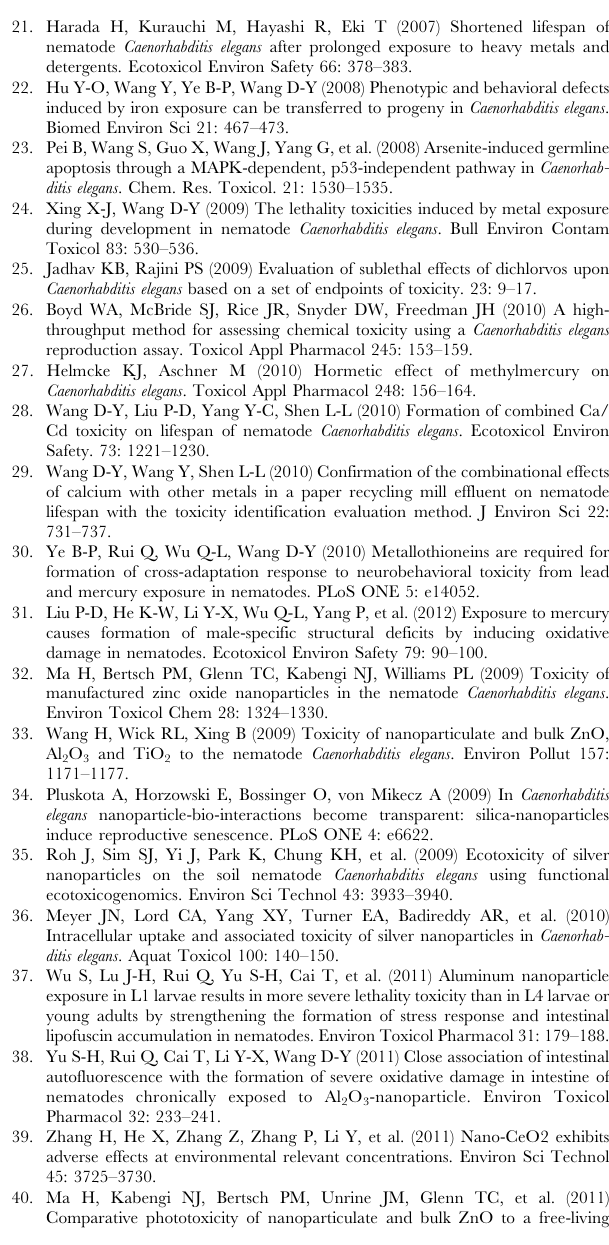
nematodes exposed to 10 m g/L of DMSA coated Fe 2 O 3 - nanoparticles from L1-larvae to day-8 adult. (B) Effects of double mutations of sod-2 and sod-3 genes on body bend in nematodes exposed to 10 m g/L of DMSA coated Fe 2 O 3 -nanoparticles from L1-larvae to day-8 adult. (C) Effects of double mutations of sod-2 and sod-3 genes on ROS production in nematodes exposed to